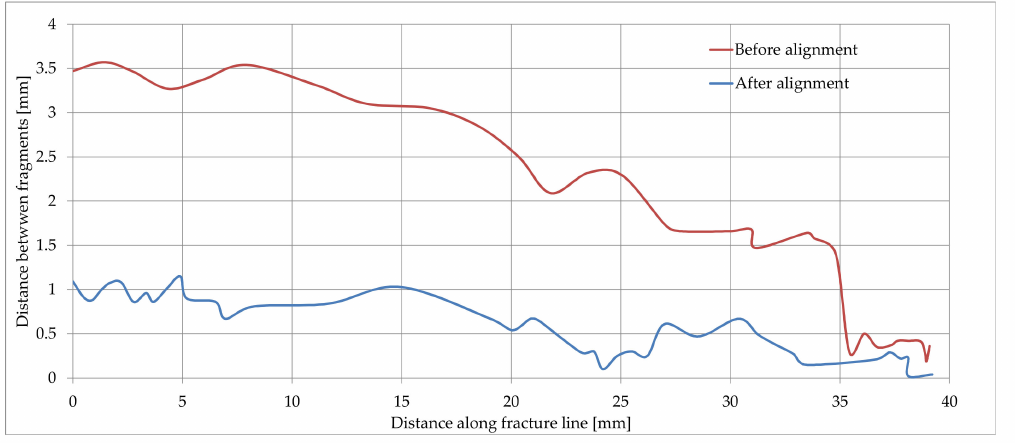
Figure 13. Variation of distances between bone fragments along the fracture line before (curve in red) and after alignment (curve in